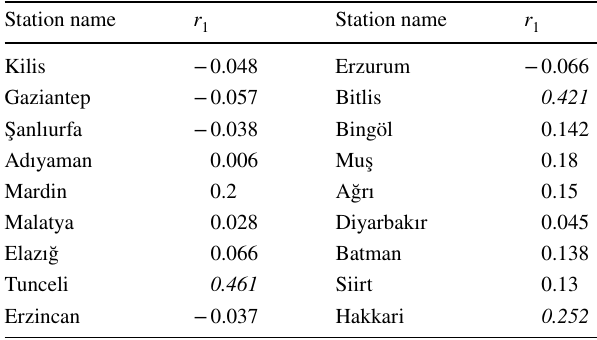
Table 2 Autocorrelation coefficients for annual total precipitation values